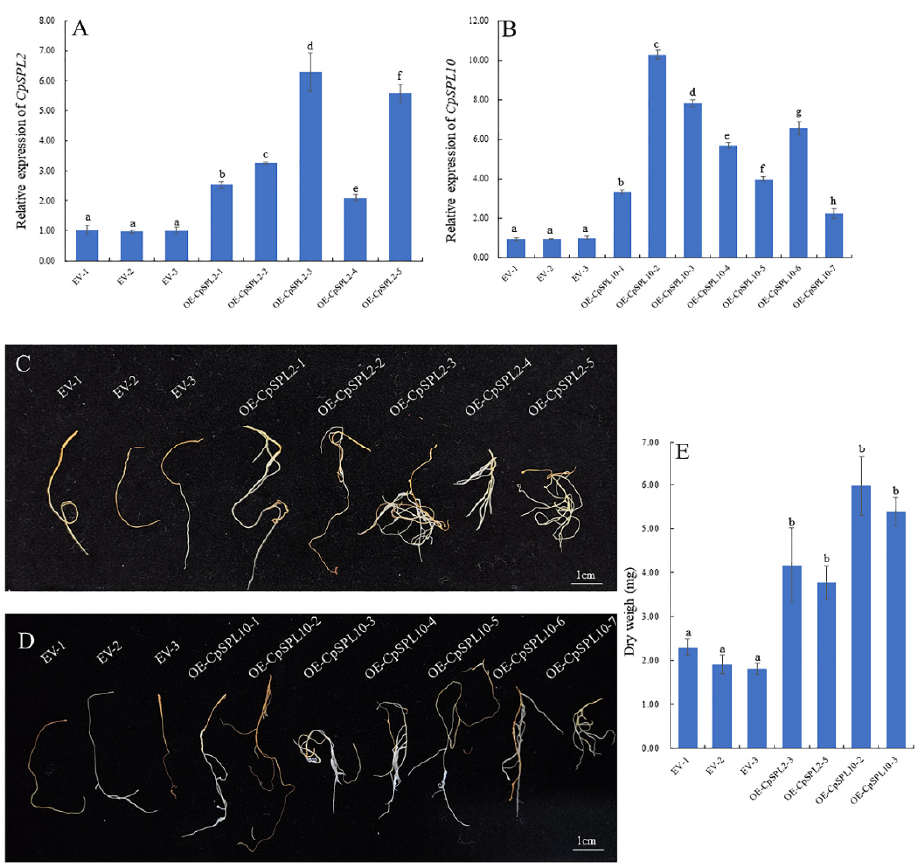
Figure 6. Identification and growth phenotype of CpSPL2 or CpSPL10 -overexpressing (OE) Codonopsis pilosula transgenic hairy roots. ( A ) Expression levels of CpSPL2 in CpSPL2 -OE lines. ( B ) Expression levels of CpSPL10 in CpSPL10 -OE lines. ( C ) Growth phenotype of empty vector (EV) and CpSPL2 -OE lines when 1 cm hairy roots were cultured for one month. ( D ) Growth phenotype of EV and CpSPL10 -OE lines when 1 cm hairy roots were cultured for one month. ( E ) The biomass of EV, CpSPL2 -OE and CpSPL10 -OE lines when 1 cm hairy roots were cultured for one month. One-way ANOVA (followed by Tukey’s comparisons) tested for significant differences among means (indicated by different letters at p < 0.05).